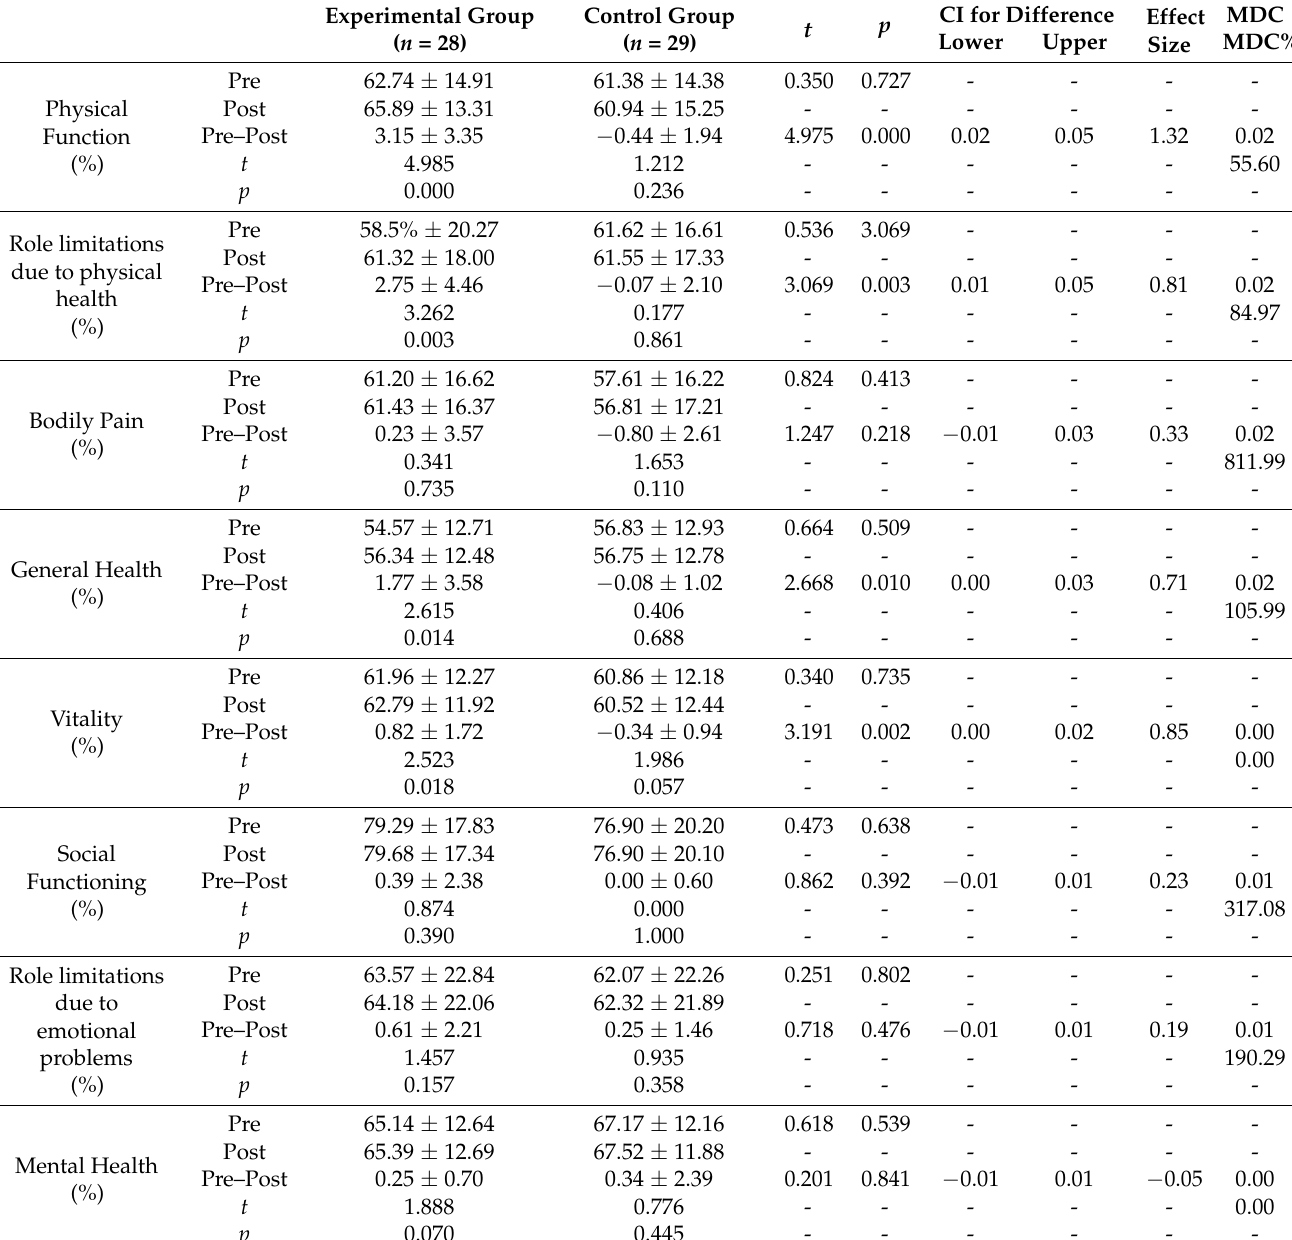
Table 4. Changes in health-related quality of